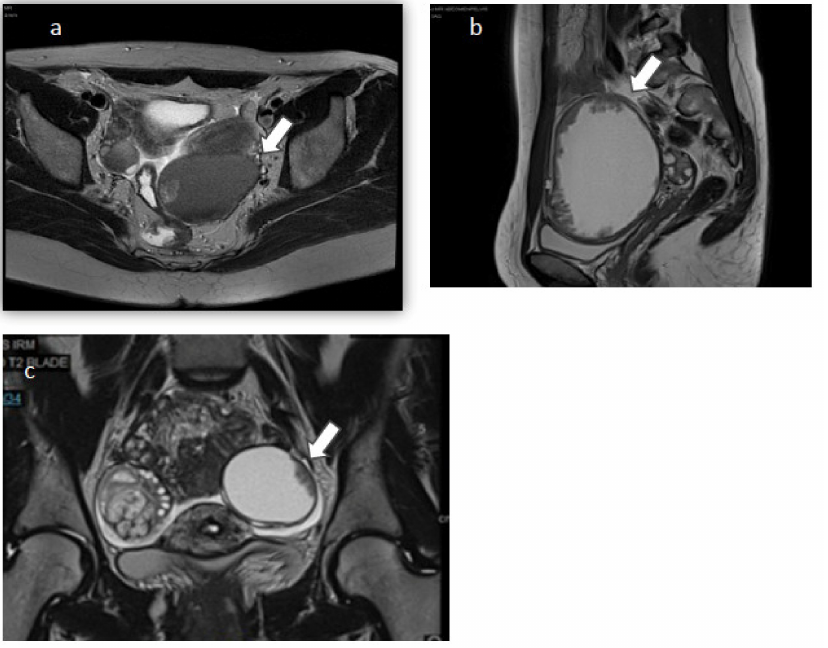
Figure 1. MRI sequences. ( a ). Case 1: Axial T2-weighed MRI sequence. ( b ). Case 2: Sagittal T2-weighed MRI sequence. ( c ). Case 3: Coronary T2-weighed MRI sequence. Arrows pointing at suspicious ovarian